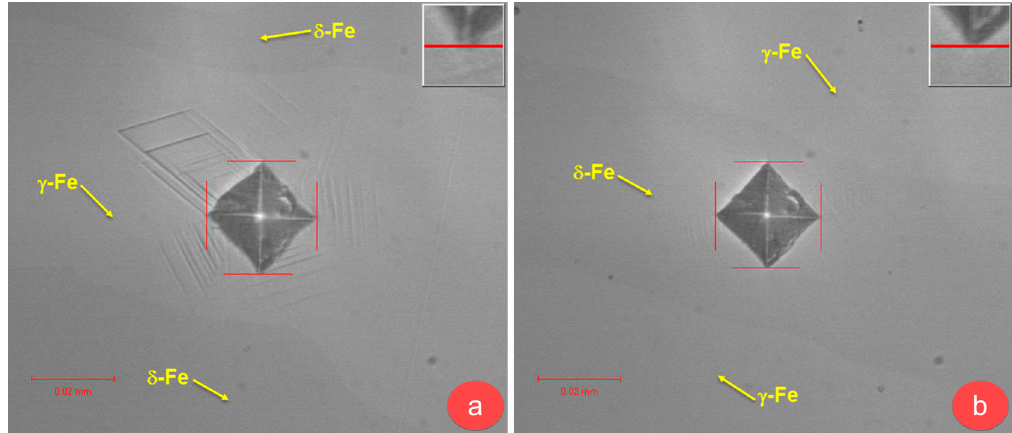
Figure 8. Microhardness indentation images on: ( a ) γ -Fe phase and ( b ) δ -Fe phase.